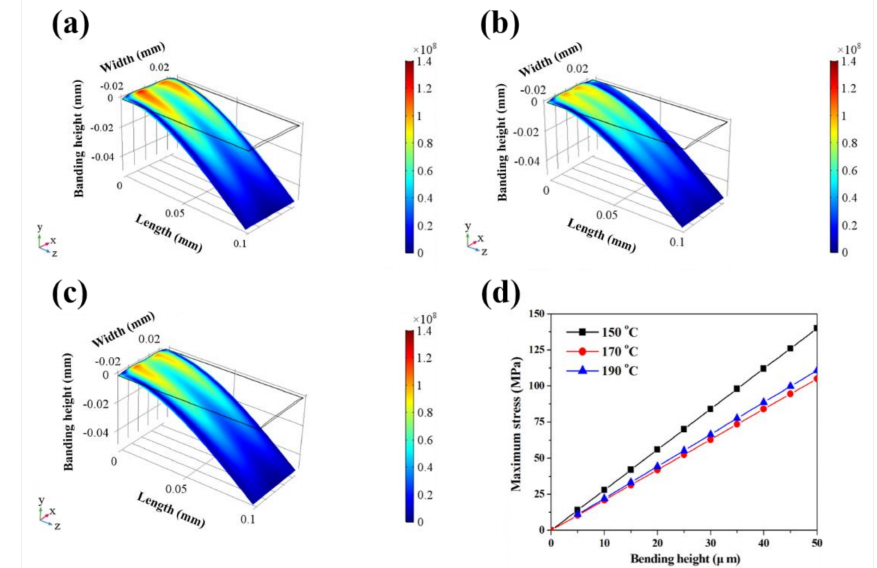
Figure 6. Simulation result of the silver electrode fabricated according to curing temperatures of ( a ) 150 ◦ C, ( b ) 170 ◦ C, ( c ) 190 ◦ C, and the ( d ) maximum bending